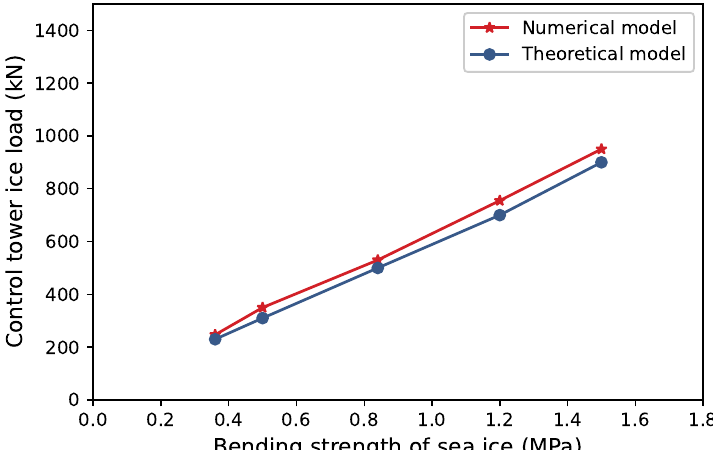
Figure 10. The relation curve between ice load and sea ice bending strength of command